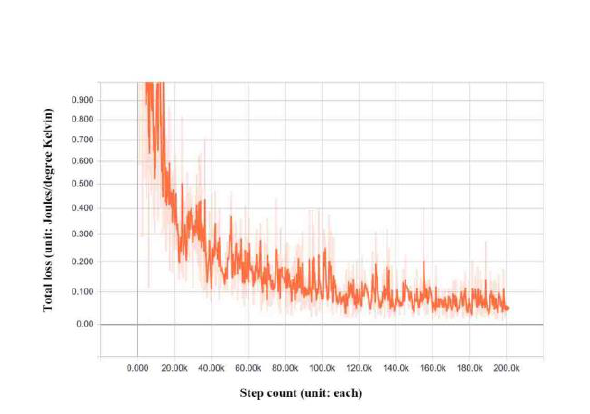
Figure 14. Total loss of resnet-v2